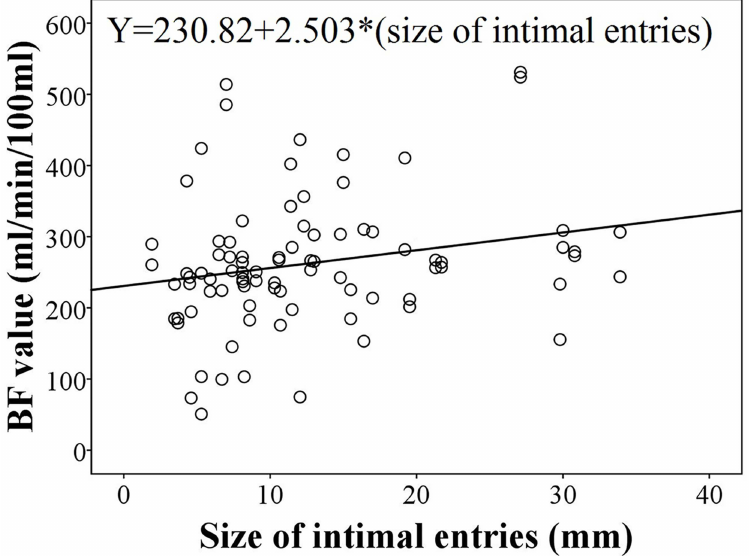
Fig 7. Result of simple regression analysis. The result indicatesthe positive correlative relationship betweenthe perfusion values and the size of intimal